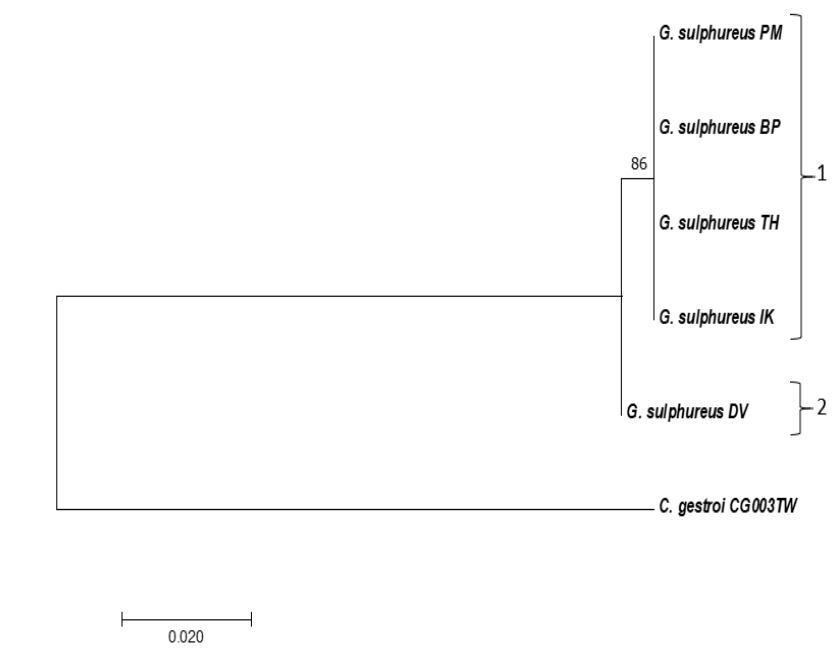
Fig 3 . Maximum likelihood tree inferred from the partial COII gene sequences of G. sulphureus from five different mounds. C. gestroi is used as an outgroup. The number at the branch refers to the bootstrap value. The evolutionary history is computed using the Hasegawa-Kishino-Yano model. Bar = 0.02 substitutions per nucleotide